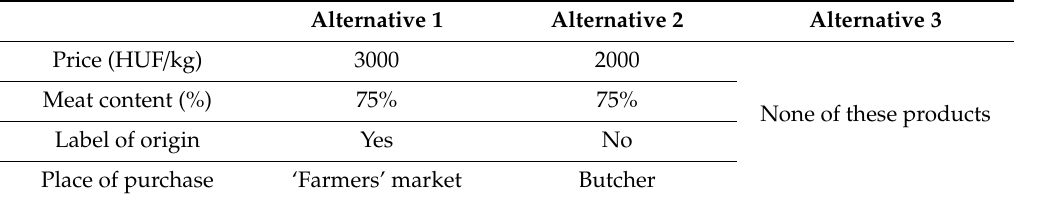
Table 2. An example of a decision